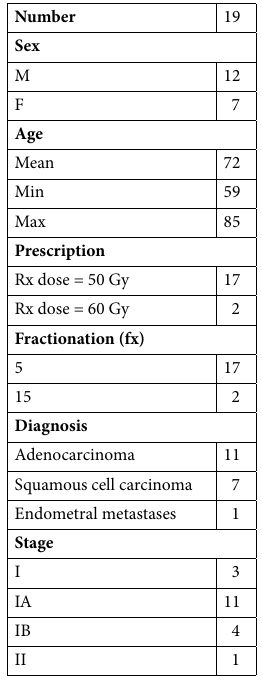
Table 1. Summary of human patient